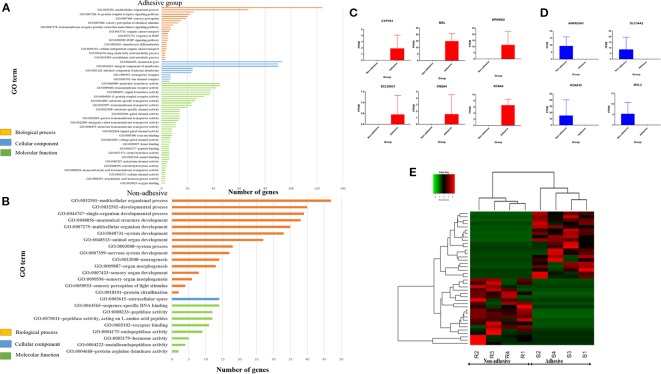
Significantly enriched (p < 0.05) GO term of genes exclusively expressed in adhesive and non-adhesive group: Biological process, cellular component and molecular function of genes exclusively expressed in adhesive group (A) and non-adhesive group (B). Graph showing some of exclusively expressed genes in small intestine epithelial cells in adhesive group (C) and non-adhesive group (D) using FPKM values. (E) Heatmap of top 20 genes exclusively expressed in adhesive and non-adhesive epithelial cells.